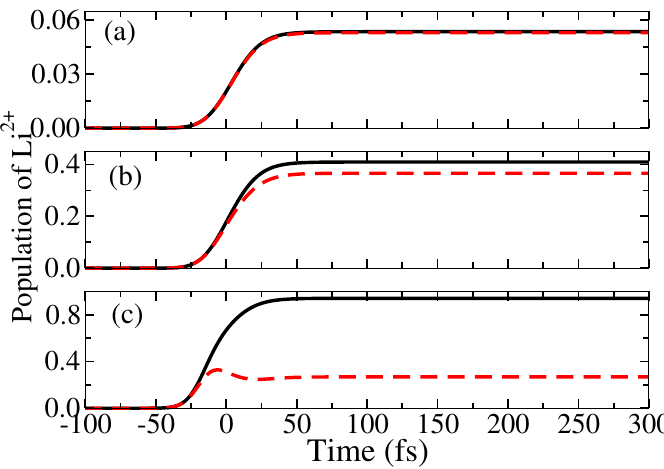
Figure 5. Effect of peak intensity on the population of Li 2 + . The peak intensities used are: 10 13 W/cm 2 for ( a ), 10 14 W/cm 2 for ( b ) and 10 15 W/cm 2 for ( c ). Black-solid curve is when the further ionization channel is ignored ( γ c = 0) and the red-dashed curve is when the further ionization channel is considered. The pulse duration τ p = 20 fs (826.8 a.u.) and the coherence time τ c = 3 fs (124.02 a.u.). The red-dashed curve suggests that for ( a ) and ( b ) the population grows after the peak intensity at t = 0 fs, but for ( c ) it drops. This causes the change in the trend of ionization of Figure